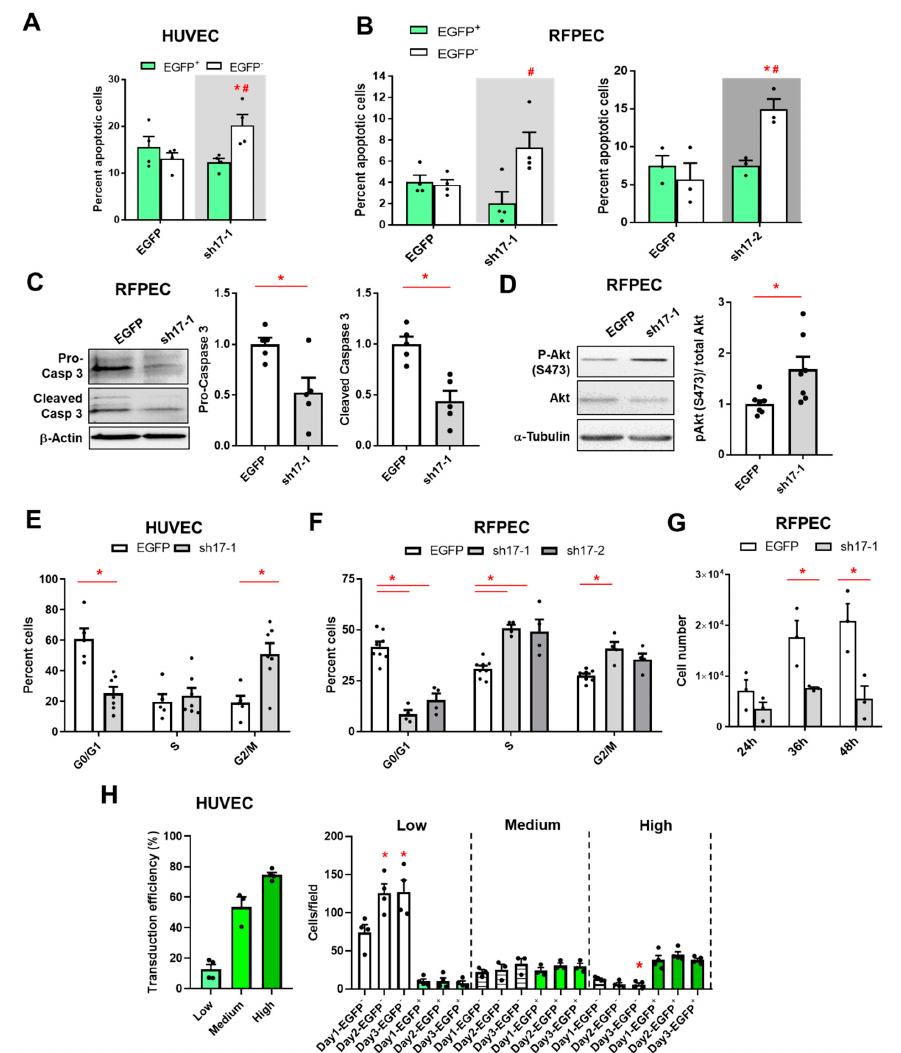
Figure 5. The reduction of RhoGEF17 prevents apoptosis and induces a cell cycle block in EC. HUVEC ( A , E , H ) or RFPEC ( B – D , F , G ) were transduced. ( A , B ) Apoptotic cells were detected by annexin-V in semi-efficiently transduced cells after 48 h. The number of apoptotic transduced (EGFP + ) and non-transduced (EGFP - ) adjacent cells are given as means + SEM with the single data points, n = 3–4, p < 0.05 * vs. EGFP-transduced, # EGFP + vs. EGFP - in sh17 transduced cells assessed by 1-way ANOVA with Tukey’s multiple comparison test. C ) Pro- and cleaved caspase 3 expression was analyzed by immunoblot in 100% transduced cells after 48 h. Representative immunoblots of both variants and β -actin ( B ) and the analyses ( C ) are shown. Quantified values are normalized by β -actin and are given relative to EGFP. Shown are the means + SEM with the single data points, n = 5, * p < 0.05 assessed by paired t-test. ( D ) Phosphorylation of Akt was detected in whole cell lysates by immunoblot 48h after transuction. Shown are representative immunoblots of pAkt (S473), total Akt and α -tubulin and the analysis. Quantified p-Akt was normalized by Akt and is given relative to EGFP. Shown are the means + SEM with the single data points, n = 7, * p < 0.05 assessed by paired t-test. ( E , F ) Cell cycle progression was analyzed by flow cytometry in cells transduced for 48 h. Calculation of G1, S, and G2/M phases are given as means + SEM with the single data points, n = 4–8, * p < 0.05 assessed by 2-way ANOVA with Sidak’s or Tukey’s multiple comparison test. ( G ) RFPEC were 100% transduced and replated. After the indicated time points cell proliferation was assessed by automated nuclei counting. The absolute cell number is given as means + SEM with single data points, n = 3, * p < 0.05 assessed by 2-way ANOVA with Sidak’s multiple comparison test. ( H ) HUVEC were seeded and transduced with different amounts of viruses in 24-well plates. One, two, and three days later images were taken and the non-transduced (EGFP - ) and transduced (EGFP + ) cells were counted manually in 160x magnification images. Left: The results were clustered according to the transduction efficiencies in low, medium, and high transduction experiments. Right: Given are the number of cells per field of view in the different conditions, n = 3–4, * p < 0.05 vs. the corresponding Day1 data as detected by 1-way ANOVA with a Dunnett’s multiple comparison